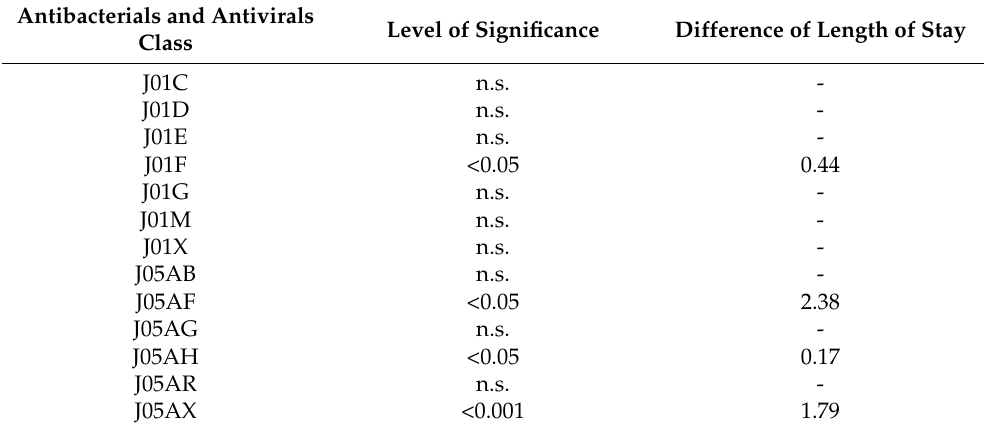
Table 6. Antibacterials and antivirals class and its effectiveness in decreasing patients’ length of stay during hospitalization.